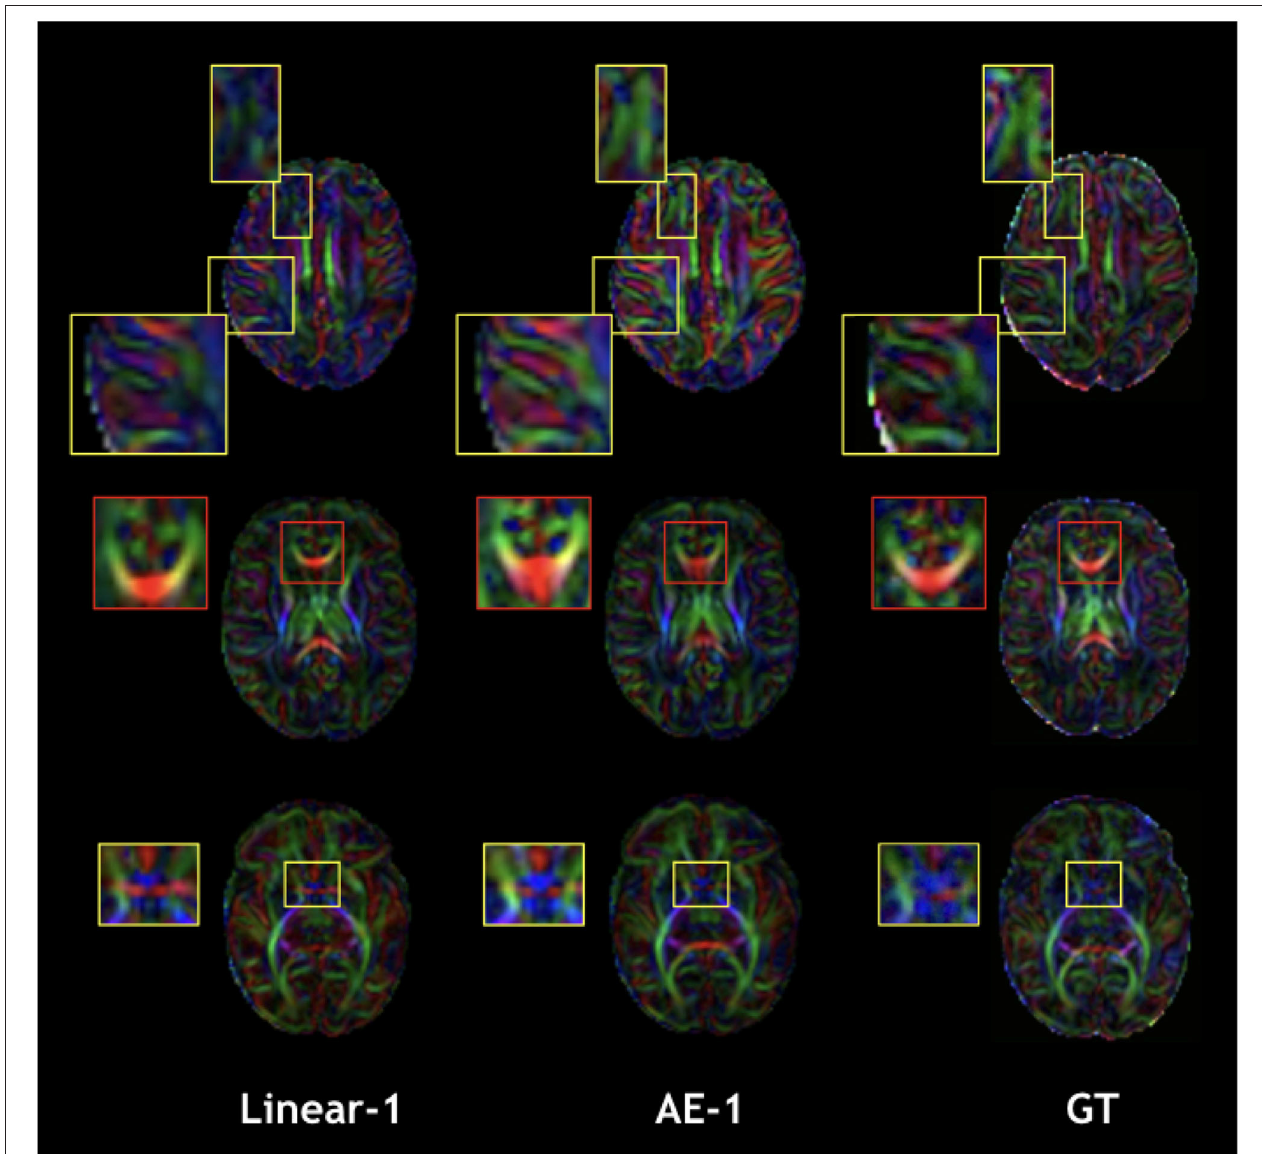
FIGURE 8 | Qualitative comparison of colored FA in the one slice removed configuration for the best baseline interpolation method, i.e., Linear-1 (left), autoencoder enhancement AE-1 (middle), and GT (right). The red frame area highlight a region where the linear interpolation shows a more accurate result.